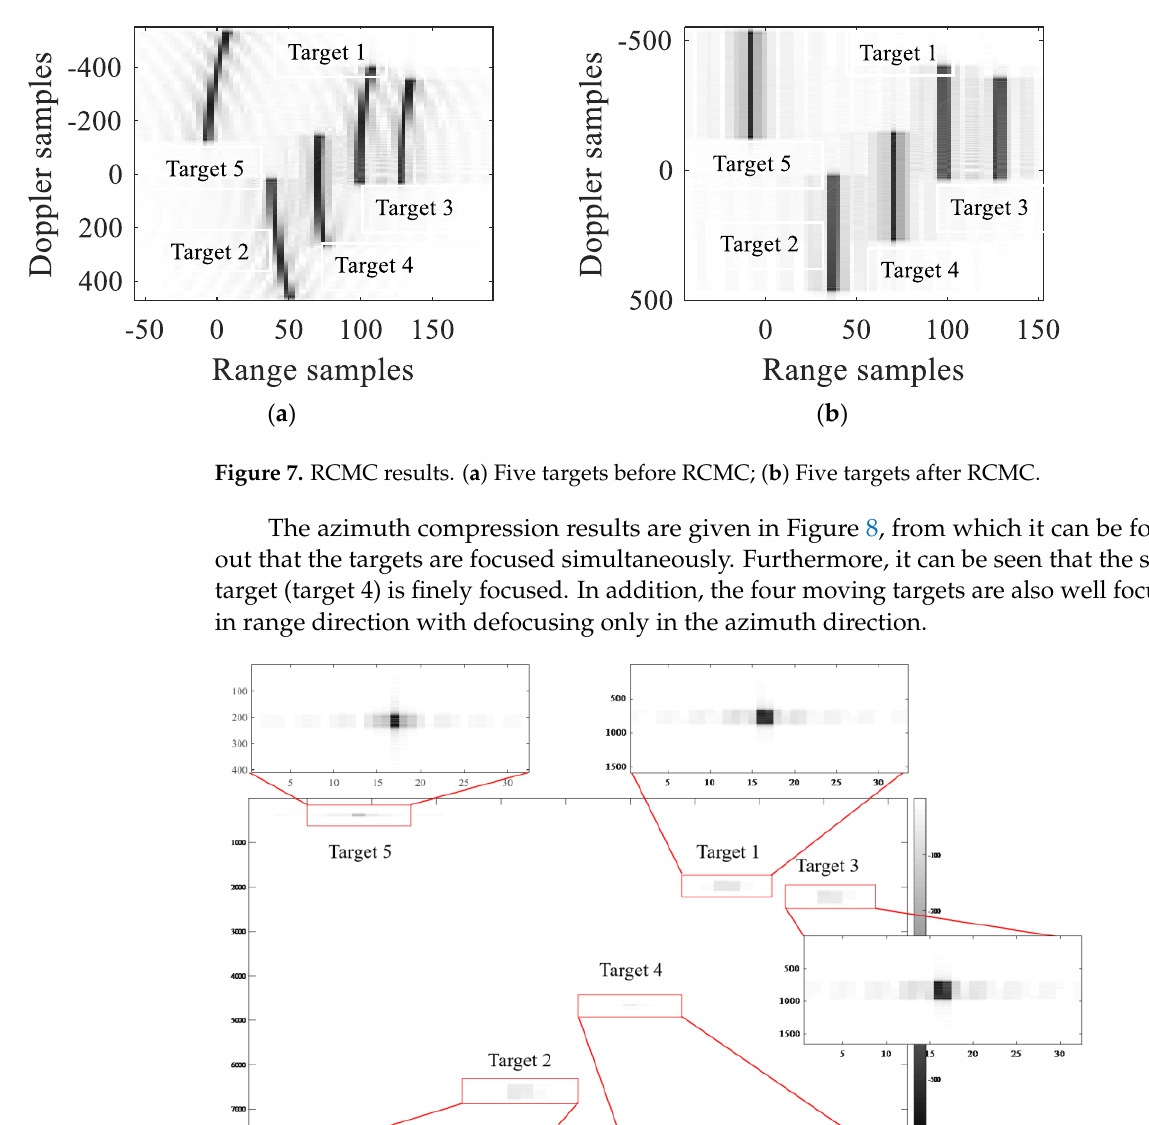
Figure 8. SAR image of the five targets.